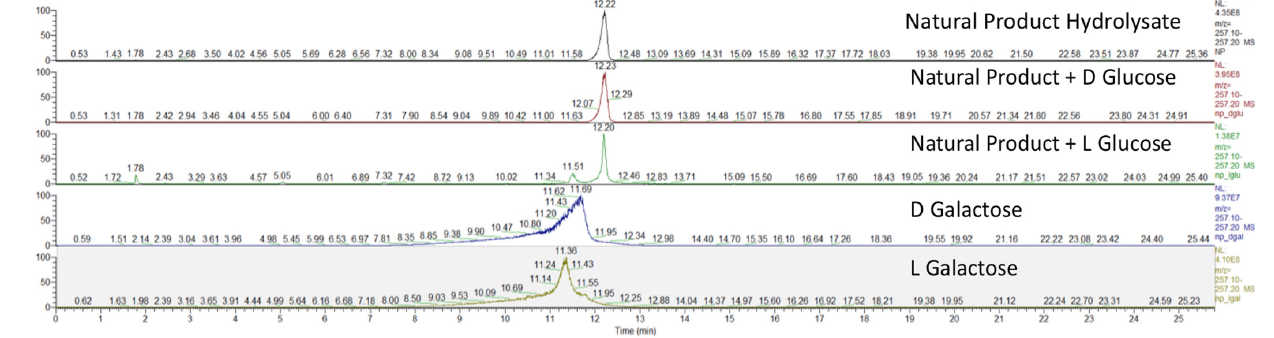
Figure 6. Extracted ion count for tanakas sugar stereochemical conformation displaying the natural product hydrolysate to have identical retention time to D-glucose.